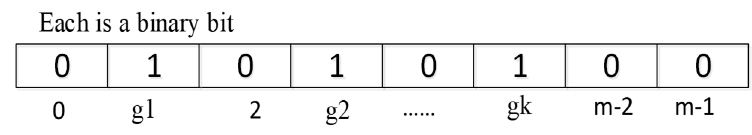
Figure 2. The working principle of Bloom filter.